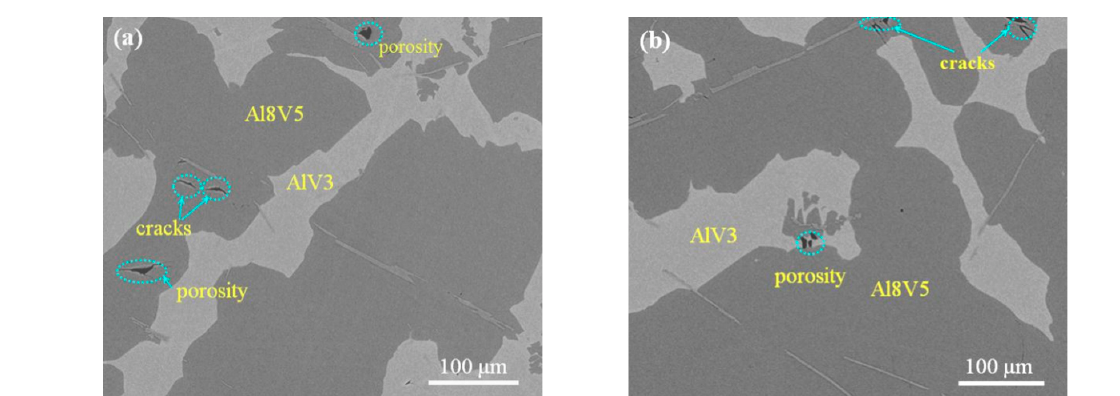
Figure 4. ( a ) Photograph of the alloy and the slag (heating time = 0 min); ( b ) photograph of the alloy and the slag (heating time = 10 min); ( c ) XRD patterns of the products obtained after reaction ( M Al : M V2O5 = 0.96:1; heating time = 10 min).